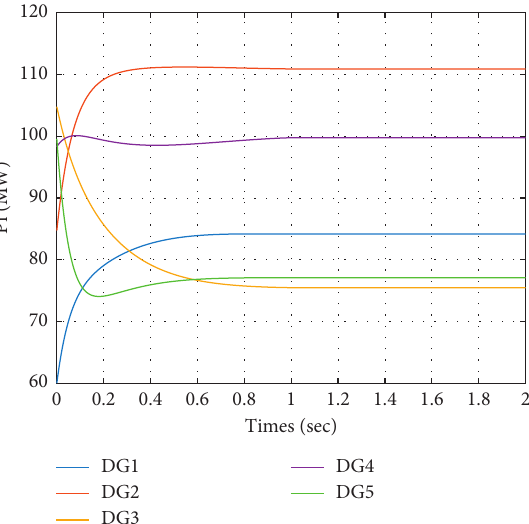
Figure 5: The output power of generator P